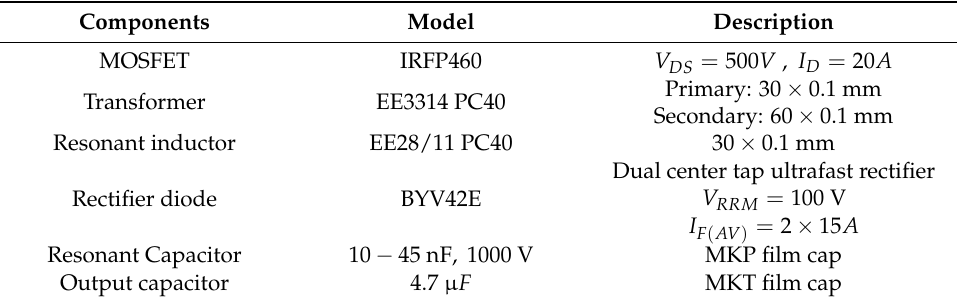
Table 4. List of